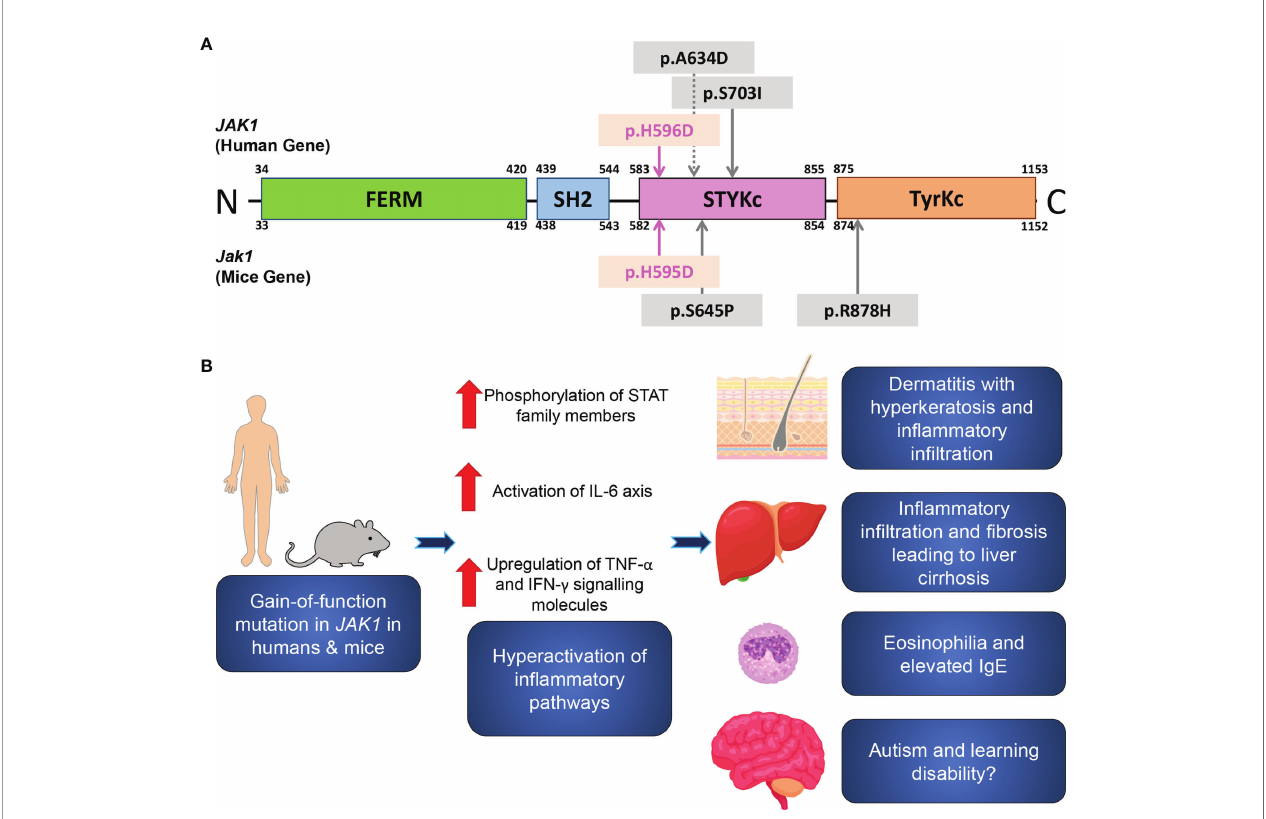
FIGURE 4 | A schematic of the JAK1 domain structure, and in fl ammatory pathways associated with JAK1 hyperactivation. (A) A schematic of the functional domains and the site of the reported gain-of-function germline mutations in humans (upper) and in mice (lower). The mutations in the present human case and in Jak1 H595D/+;I596I/+;Y597Y/+ mice are marked by pink arrows. Sites of the previously reported mutations are indicated by grey arrows. FERM, FERM (F for 4.1 protein, E for ezrin, R for radixin and M for moesin) domain; SH2, Src homology 2 domain; STYKc, the serine-threonine/tyrosine-protein kinase, catalytic domain (also called the pseudokinase domain); TyrKc, the tyrosine kinase catalytic domain. (B) Theory on the pathogenesis of the in fl ammatory pathways associated with JAK1